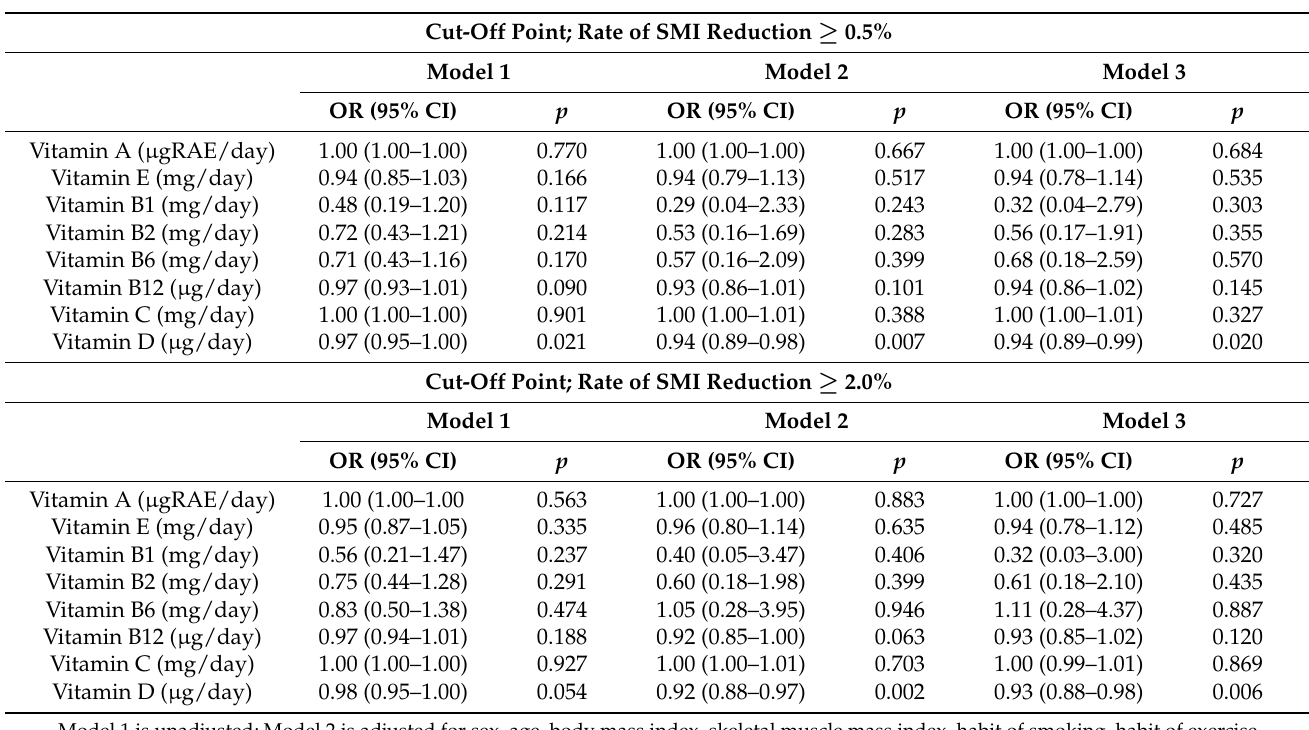
Table 4. Odds ratio of the quantity of vitamin intake on the presence of the loss of muscle mass according to the difference cut-off point.